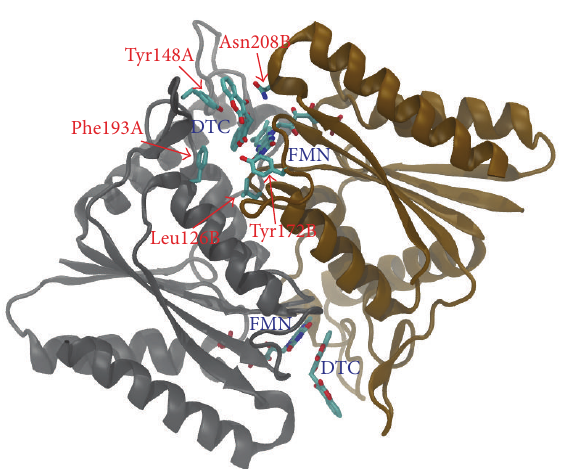
Figure 3: Comparative model of S. aureus azoreductase in complex with FMN and dicoumarol. The protein model is a homodimer composed of two ligand-binding sites located at the dimer interface. FMN, dicoumarol (DTC), and the conserved binding residues are shown in stick